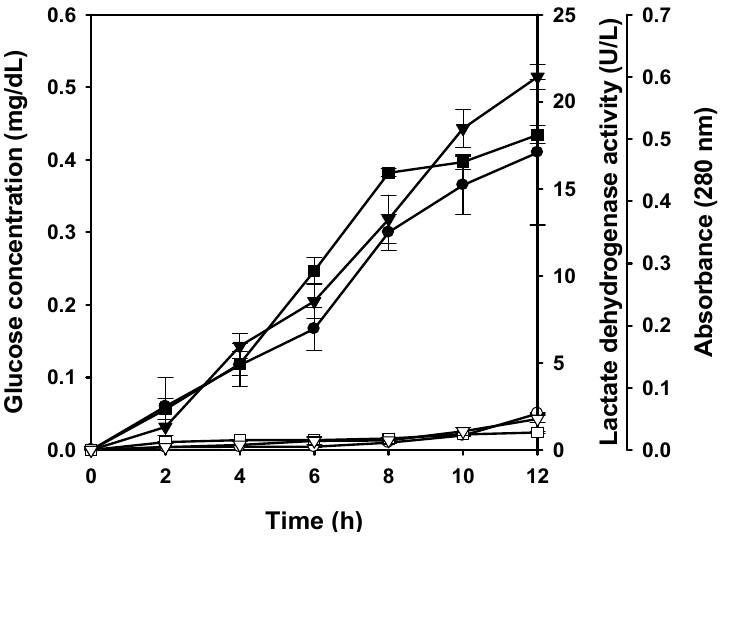
Figure 3. Effect of water-soluble chitosan derivative (GN70-3) at the concentration of 250 mg/L on glucose concentration ( ○ and ● ), lactate dehydrogenase activity ( □ and ■ ) and protein level ( ▽ and ▼ ) in the extracellular media of S. aureus cultured in deionized water at 37 °C up to 12 h. Open symbols ( ○ , ▽ , □ ) indicates cells without chitosan treatment, while solid symbols ( ● , ▼ , ■ ) indicated cells with chitosan treatment. Each value is expressed as mean ± SD (n =